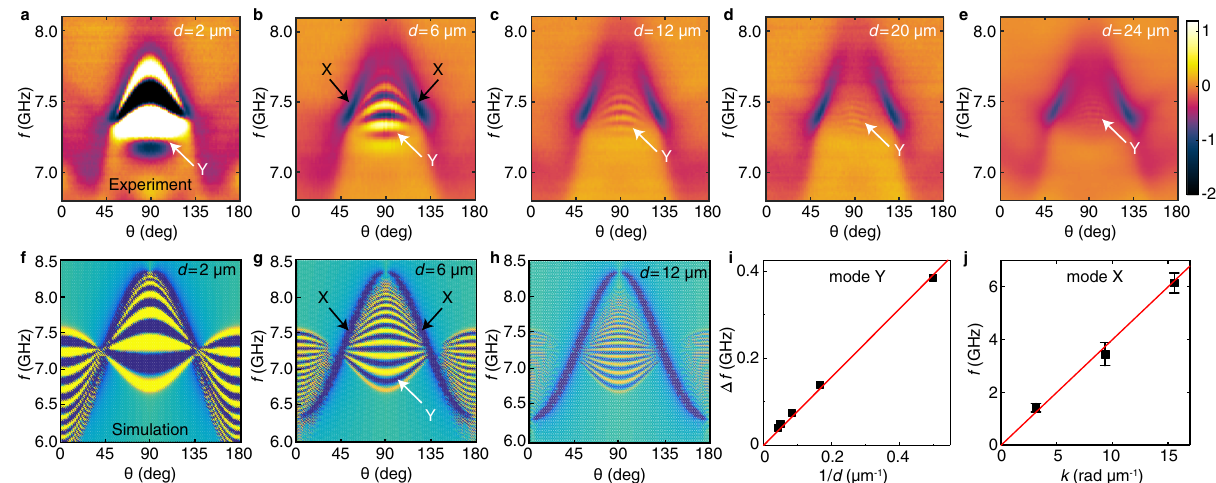
Fig. 2 Distance-dependent transmission spectra and spin-wave group velocities. a – e Transmission spectra S 21 measured as a function of fi eld angle θ from 0 to180 degree on Samples Z01, Z02, Z07, Z08, and Z09 with spin-wave propagation distances d of 2, 6, 12, 20, and 24 µ m, respectively. The spin-wave wavevector k is along the LSMO [110] direction. The data displayed in the map is the imaginary part of the transmission spectra, and the color bar denotes the amplitude of the imaginary part, which is in arbitrary units. f – h Simulation results of angle-dependent spin-wave transmission over 2, 6, and 12 µ m. The color code is taken from the real part of the total transmission signal s ð d Þ picked by the NSL or CPW in the simulations (see Supplementary Sec. V). i Peak-to-peak frequency span 4 f extracted from signals attributed to mode Y in a – e at θ ¼ 90 (cid:3) and plotted as a function of 1 = d . The linear fi t (red line) yields an average group velocity of 0.8kms − 1 . j The dispersion relation obtained by frequencies f of mode X extracted from the fi eld-dependent transmission spectra at 54° (Supplementary Fig. 11) and wavevectors k from the Fourier transformation of CPWs (Supplementary Fig.